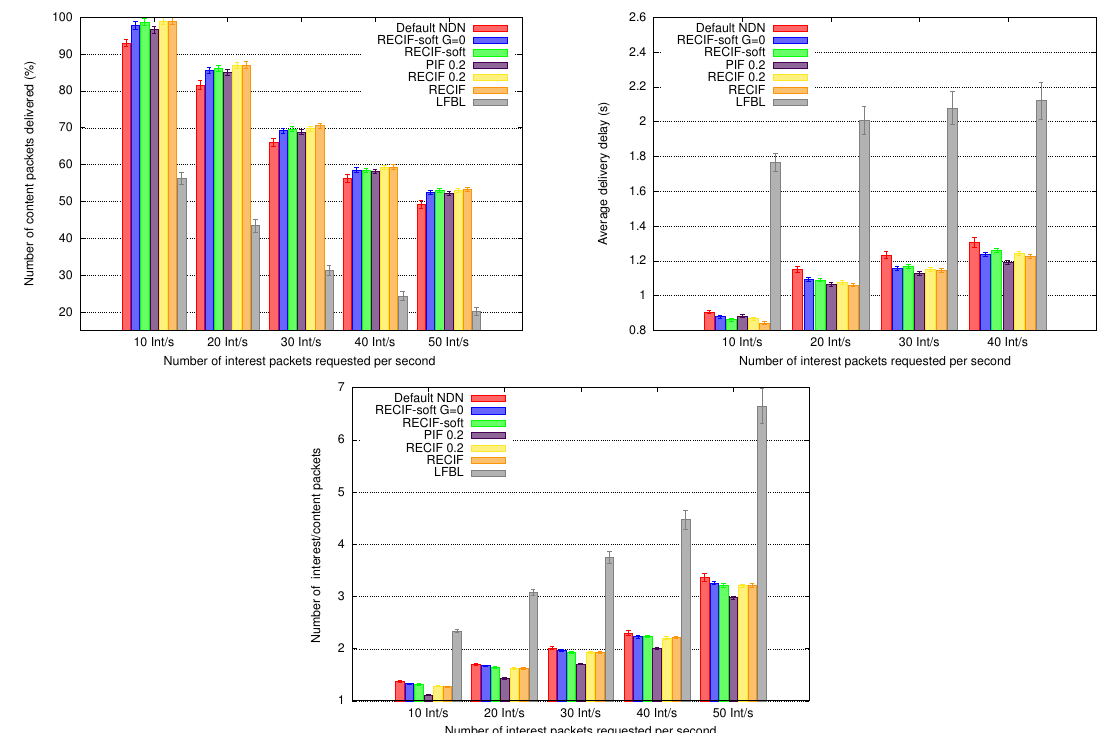
Figure 8. Content packets delivered, average delivery delay, and overhead for 30 consumers requesting popular contents at different